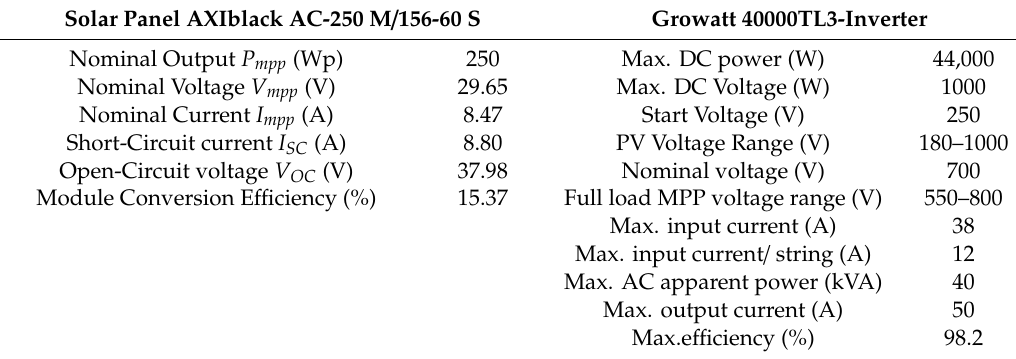
Table 5. Preferred Solar Panel and Inverter